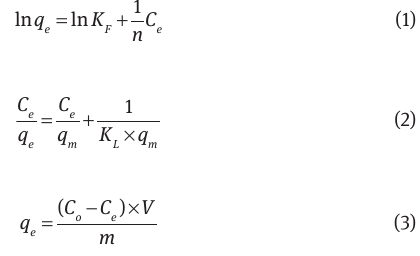
Figure 1: The synthesis of RHA/Al(OH)